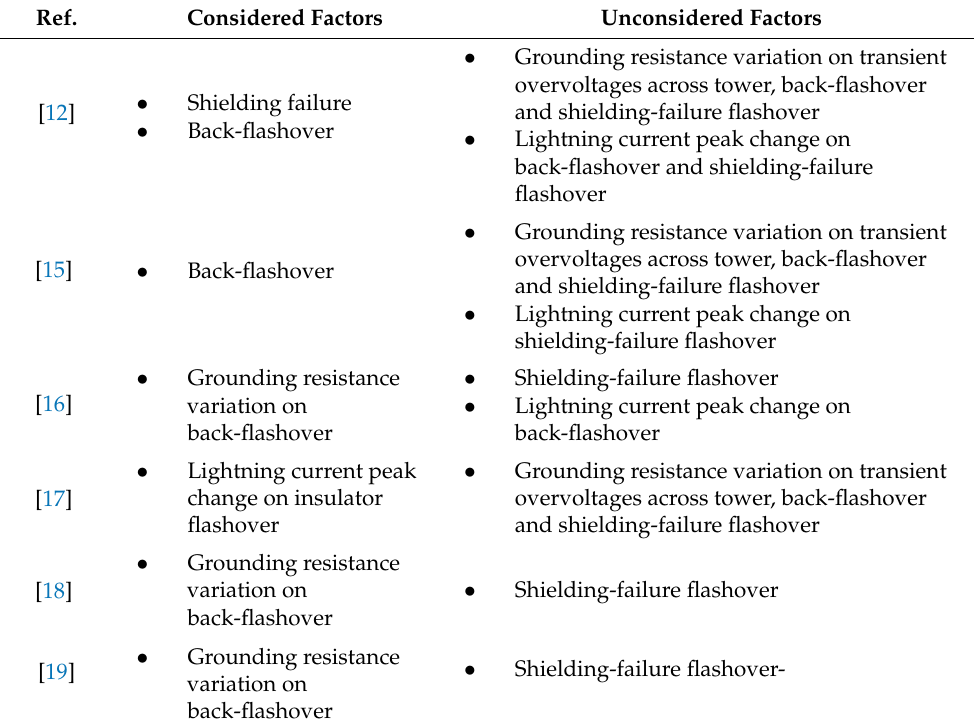
Table 1. Summary of the literature review.